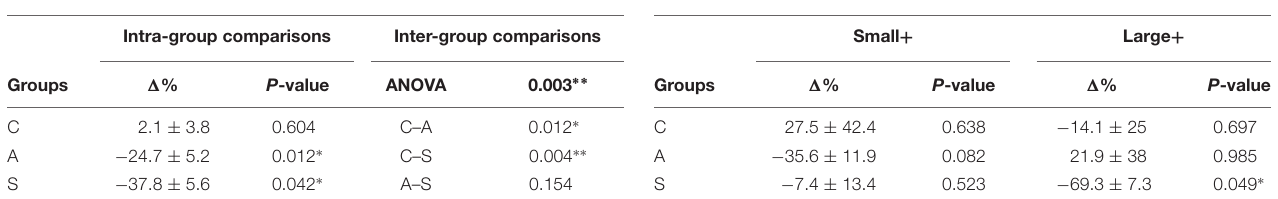
TABLE 1 | OM region. TABLE 2 | OM